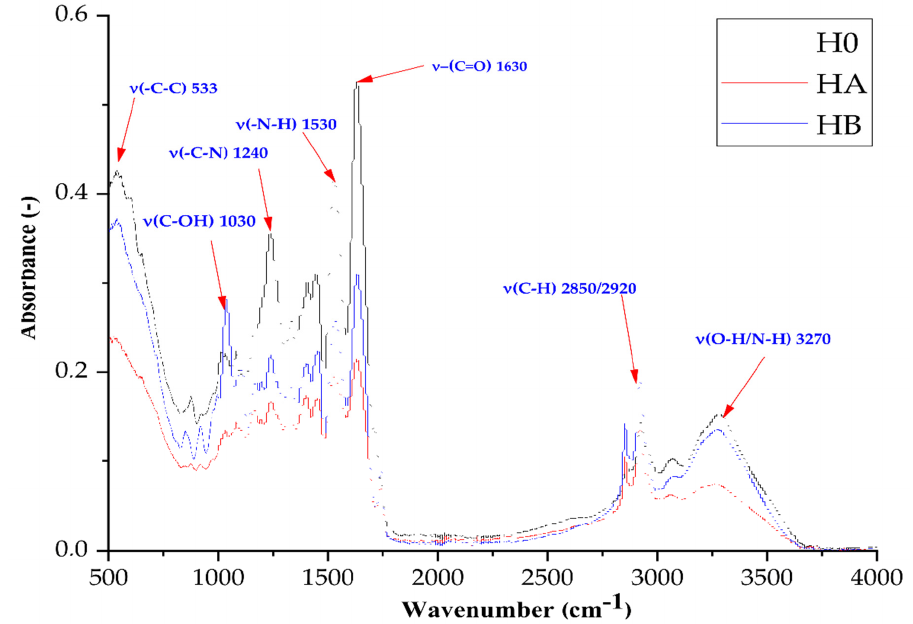
3 Figure 3. FTIR spectra of polymer composites. The black line represents the H0 composite, the red line represents the HA composite, and the blue line represents the HB